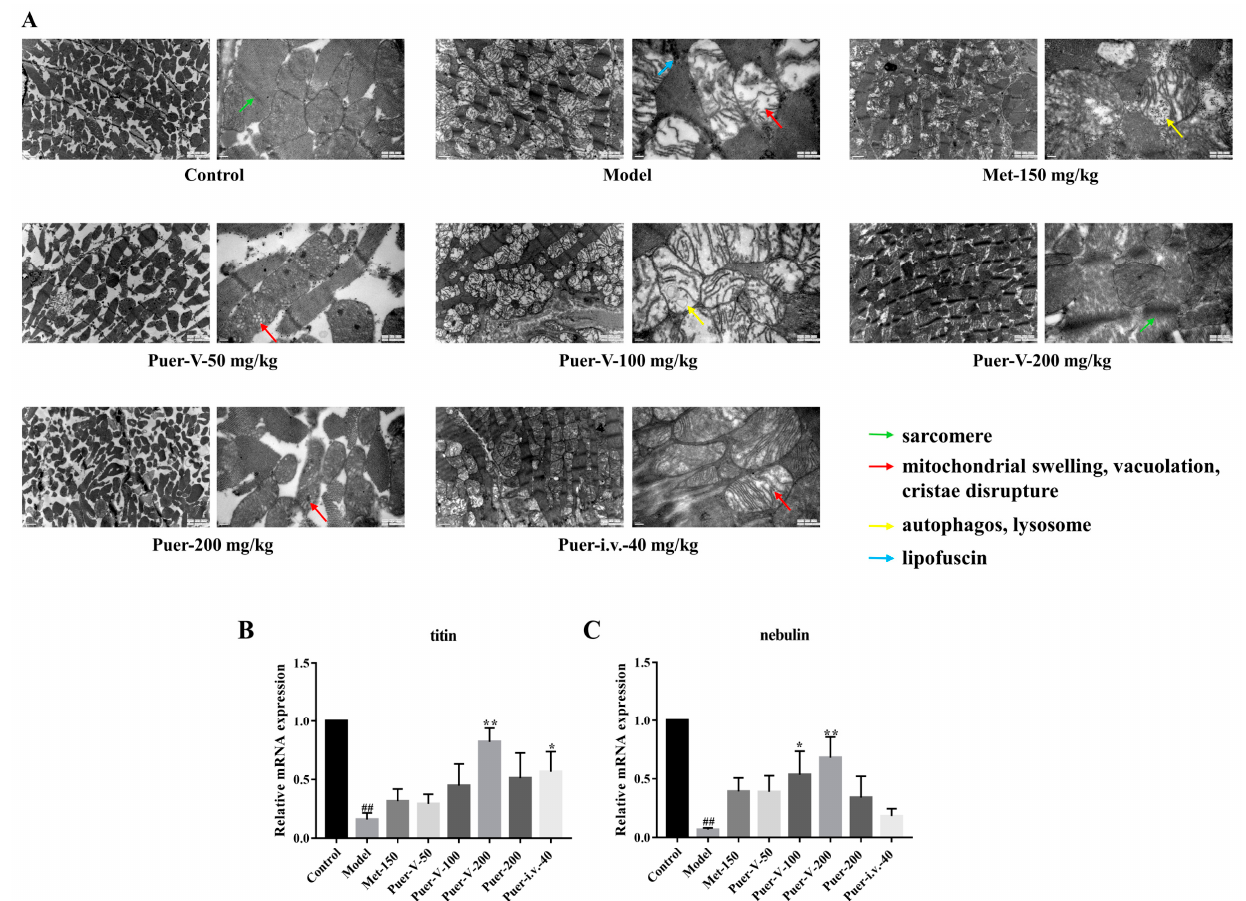
Figure 8. Puerarin-V preserved the myocardial integrity in the DCM rats. ( A ) Alteration of ultrastructure of cardiac muscle cells. Quantitative Real-Time Polymerase Chain Reaction (RT-PCR) detection of skeleton protein titin ( B ) and nebulin ( C ) mRNA expression in myocardial tissue. The data are represented by mean ± SEM (n = 6–8). ## p < 0.01 vs. control group. * p < 0.05 and ** p < 0.01 vs. model group.